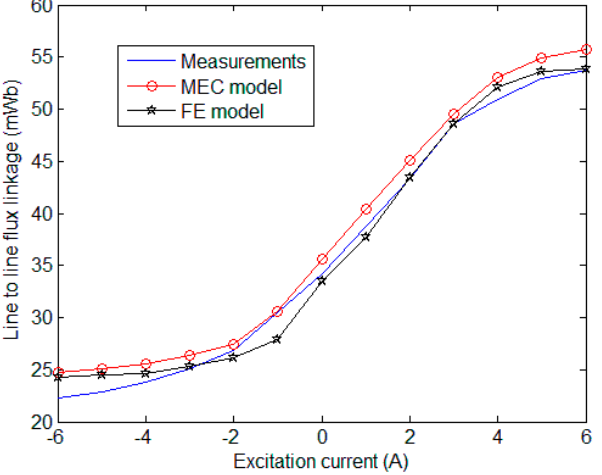
Figure 29. Open-circuit line-to-line maximum flux linkage variations with I exc .